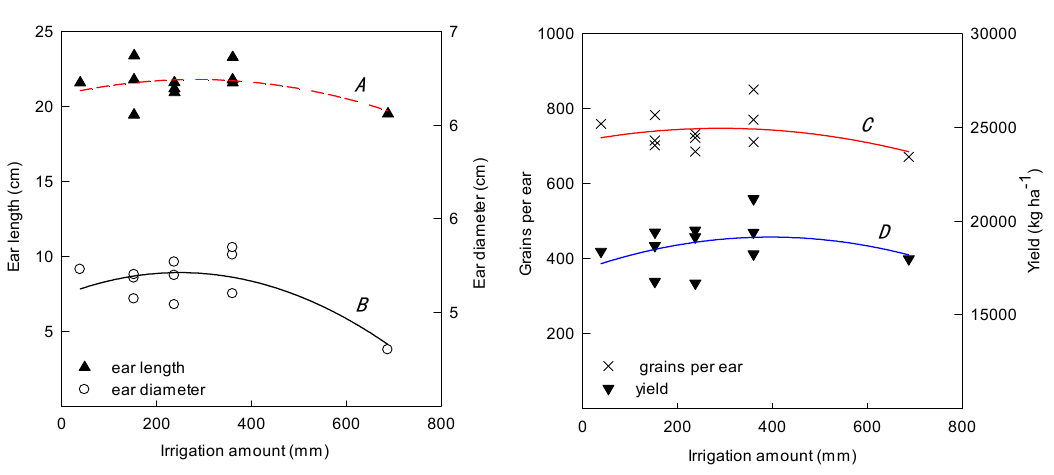
Figure 8. The relationships between irrigation water and ear length, ear diameter, and grains per ear, as well as grain yield. A , B , C , and D represents changes of ear length, ear diameter, grains per ear, and yield with irrigation water, respectively. Table 5. Results from two-way ANOVA of the effect of various patterns of RFPS and irrigation levels on ET c , k c , and daily water